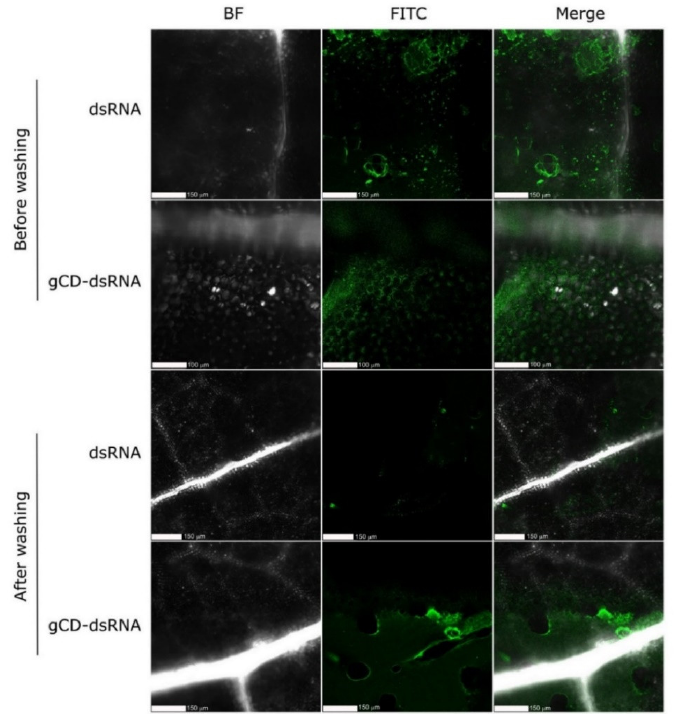
Figure 8. Confocal microscopy of cucumber leaves treated with dsRNA*FITC and gCD-dsRNA*FITC before and after washing them with distilled water. Column 1: bright-field (BF) images; column 2: FITC fluorescence images; column 3: BF and FITC merged images.